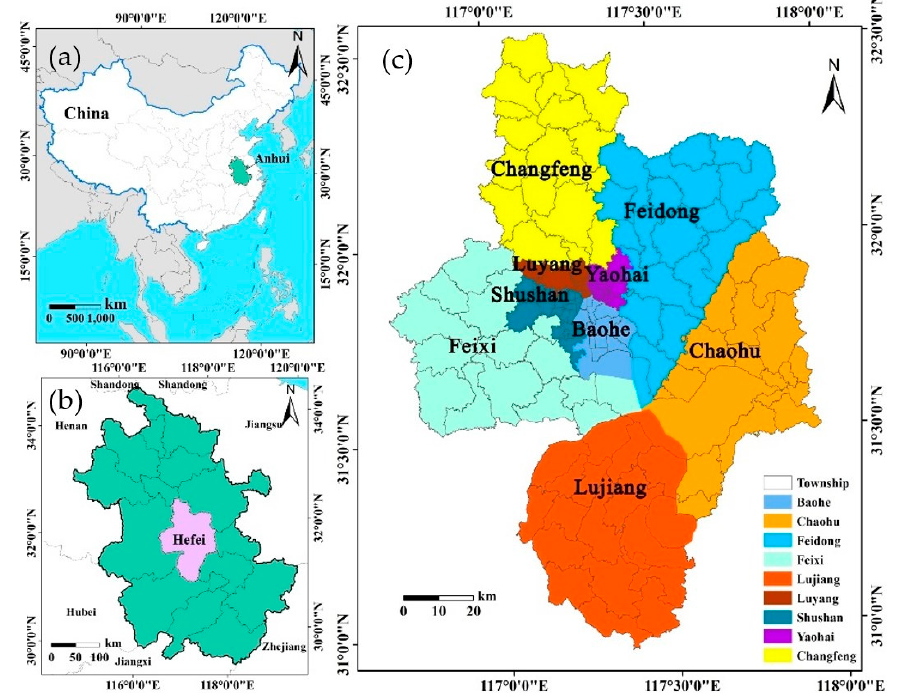
Figure 1. Location of study area; ( a ) Location of Anhui Province in China; ( b ) Location of the study area in Anhui Province; ( c ) The administrative division map of study area, and the minimum level are townships.